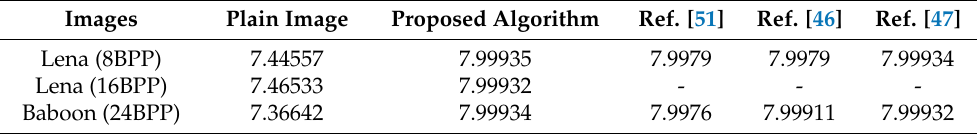
Table 14. Shannon